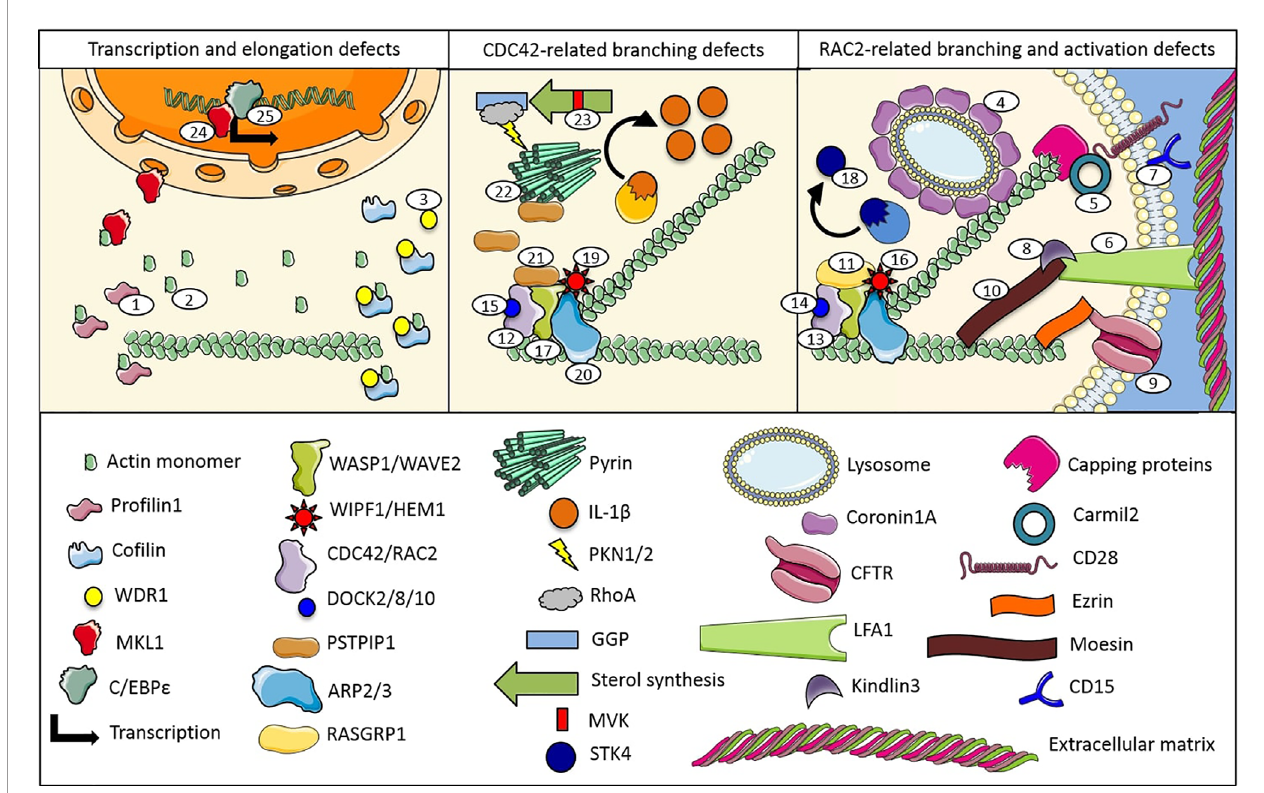
FIGURE 1 | Proteins and pathways involved in monogenic immune system diseases characterized by actin remodeling defects (numbers are related to the manuscript and Table 1